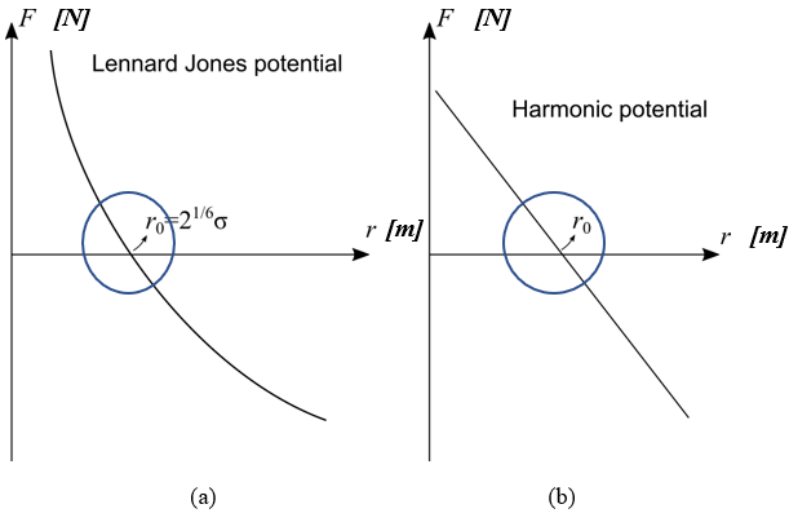
Figure 2. ( a ) Lennard Jones potential and ( b ) Harmonic potential. Table 1. Lennard Jones and Harmonic potentials and forces.